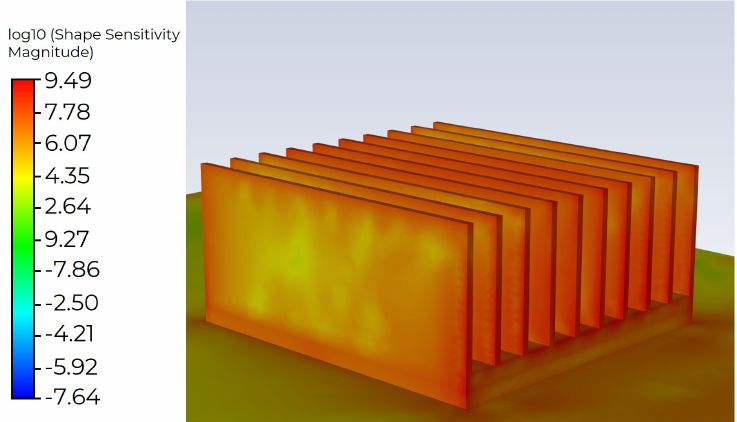
Figure 19. Sensitivity of heat sink shape expressed by the log10